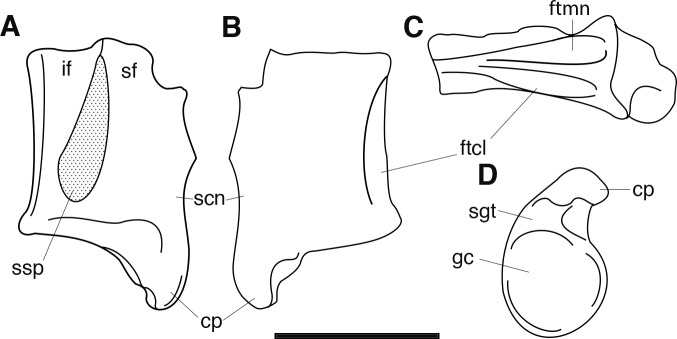
Annotated line drawing of the right scapula of Periptychus carinidens (NMMNH P-47693).(A) lateral view; (B) medial view; (C) posterior view; (D) distal view. Abbreviations: cp, coracoid process; ftcl, fossa for the origin of the caput longum of the triceps; ftmn, fossa for the origin of the teres minor; gc, glenoid cavity; if, infraspinatus fossa; scn, scapular notch; sf, supraspinatus fossa; sgt, supraglenoid tubercle; ssp, scapular spine (damaged). Scale bar: 30mm.